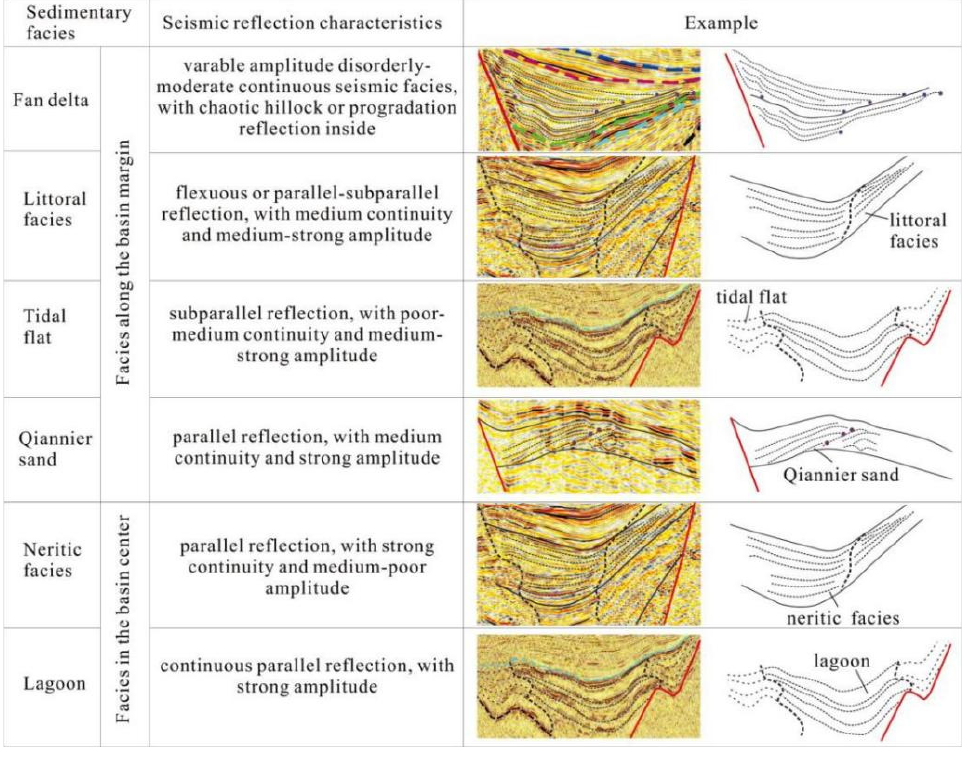
Figure 4. The sedimentary facies and relevant seismic facies developed in the Paleogene study area.